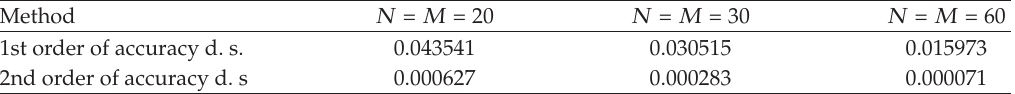
Table 1: Comparison of the